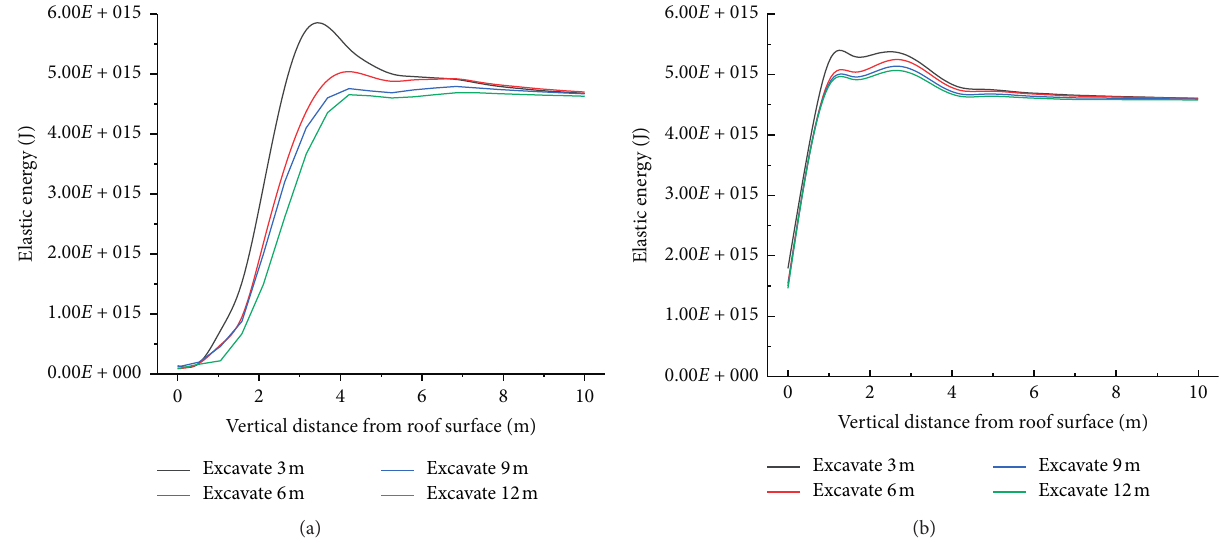
Figure 11: Elastic energy evolution under different excavation distance without and with surrounding rock grouting. (a) Without sur- rounding rock grouting. (b) With surrounding rock